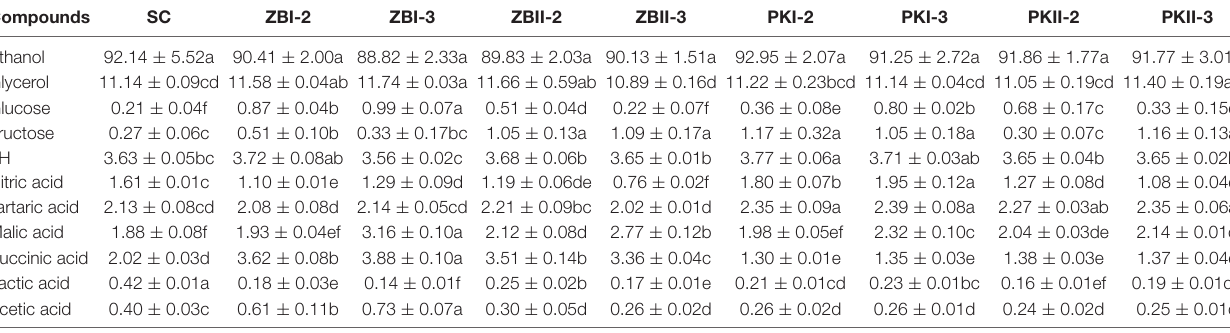
TABLE 1 | Physicochemical parameters (g/L) of the final wines after alcoholic fermentation. Compounds